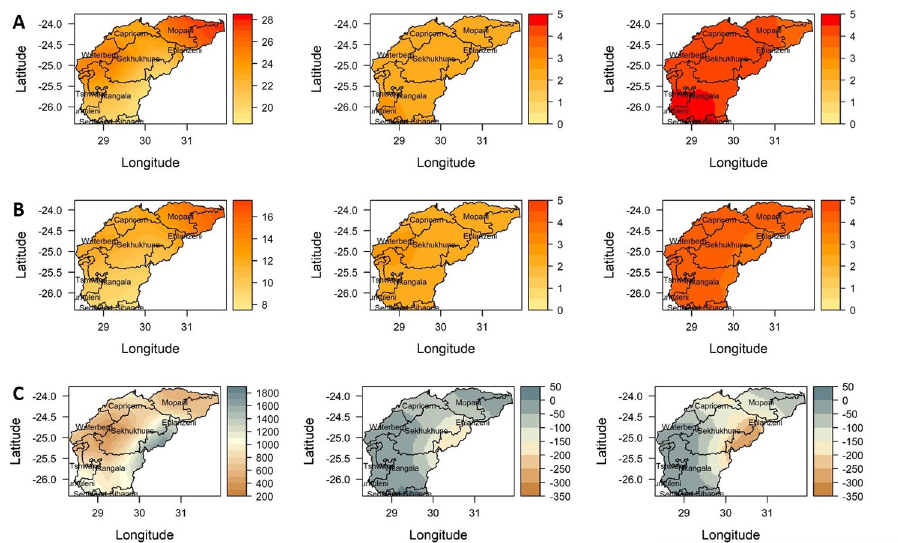
Fig 6. Projected changes in annual (A) mean maximum, (B) minimum temperature and (C) total rainfall, for 2036– 2065 (2nd column) and 2066–2095 (3rd column) periods under scenarios of the RCP8.5 relative to the baseline period 1976–2005 (1st column) over the Olifants River Catchment. "Basemap (Water management shapefile was collected from the South Africa National Department of Water and Sanitation on http://www.dwa.gov.za/iwqs/gis_data/"